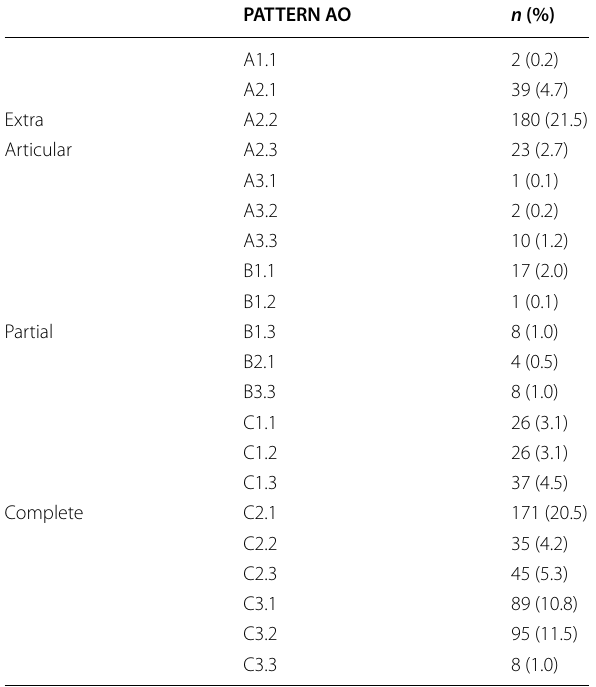
Table 1 Fracture pattern according to AO/OTA distal radius fracture classification system